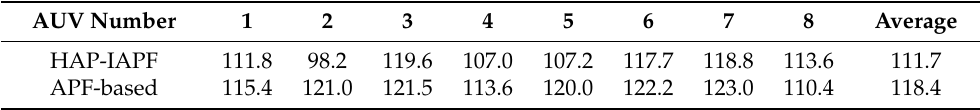
Table 3. Path length of each AUV during 20–60 steps (unit: